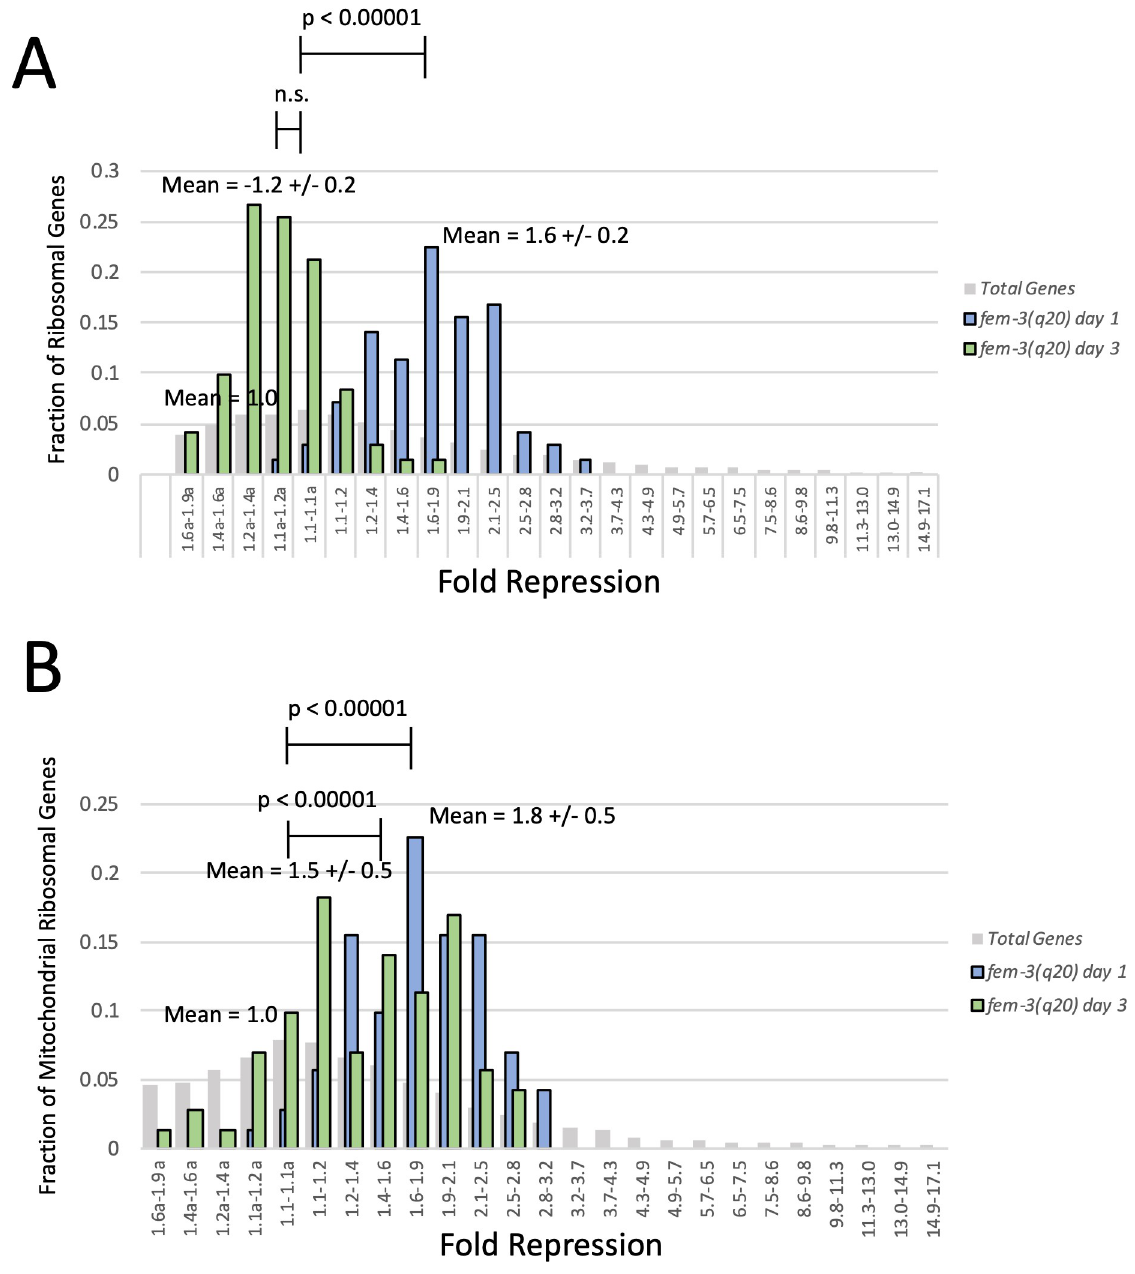
Fig 5. Repression of Ribosomal Protein Genes in fem-3(q20) Mutants. (A) Histograms of cytosolic ribosomal protein genes in a fem-3 (q20) mutant binned by fold repression/activation. Data represent the fraction of cRPGs residing in each range of repression. Blue bars represent repression between L4 and day 1 of adulthood and green bars represent repression between L4 and day 3 of adulthood. Means represent the average repression of all ribosomal protein genes in day 1 or day 3 adults and are shown along with standard deviations. Data show that cRPGs are mildly repressed by 1.6-fold between L4 and day 1 of adulthood (P value < 0.00001). In contrast to glp-1(e2141) animals, however, cRPGs are not further repressed in the fem-3(q20) day 3 adults. In fact, between L4 and day 3 of adulthood cRPGs are not significantly repressed at all in the fem-3(q20) mutant. (B) Histograms of mitochondrial ribosomal protein genes (mRPGs) binned by fold repression. Data represent the fraction of all mRPGs residing in each range of repression. Blue bars represent repression between L4 and day 1 of adulthood and green bars represent repression between L4 and day 3 of adulthood. Data show that mRPGs are mildly repressed in day 1 adults (mean = 1.8-fold), but not further repressed in day 3 adults (mean = 1.5-fold). Repression in both day 1 and day 3 adults is highly significant compared to total genes (P values < 0.00001). Data are derived from 3 biological replicates. Statistics were calculated using a T- test for two independent means. E.g., the mean of all cRPGs vs the mean of total genes.